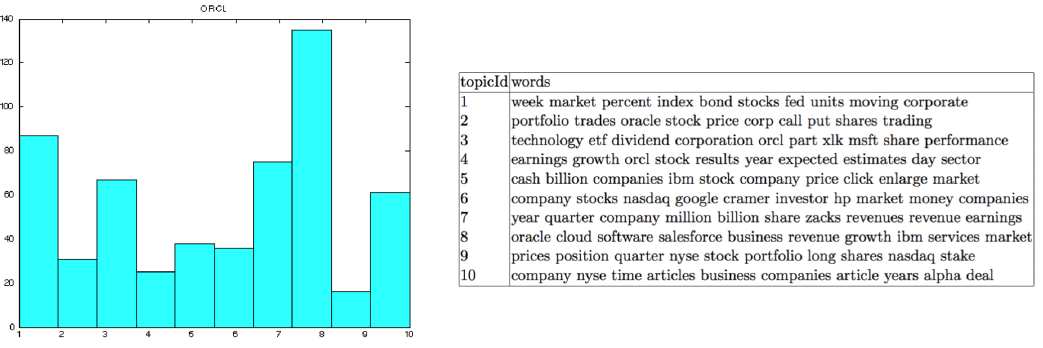
Figure 15. Topic modeling for ORCL stock. The y -axis represents the number of texts in each topic, and the x -axis represents the